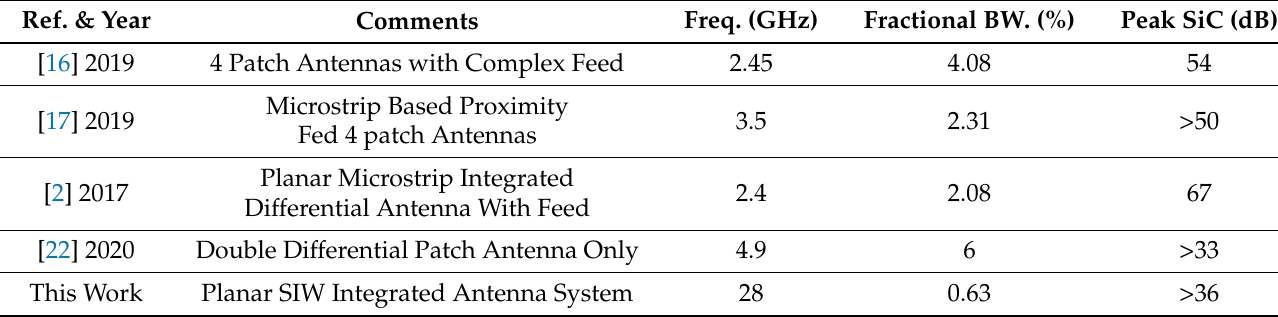
Table 1. Comparison with published